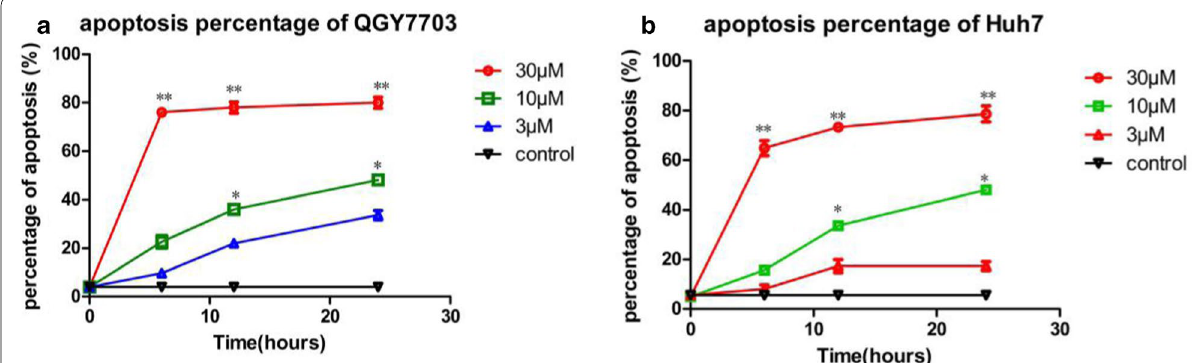
Fig. 3 Vanoxerine dihydrochloride treatment induced cell apoptosis. Vanoxerine dihydrochloride treatment at at 3, 10, 30μMconcentration for 6, 12, 24 h significantly increased the percentage of apoptosis in a QGY7703 and b Huh7 cell lines in a dose‑and time‑dependent manner. *p < 0.05, significantly different from the control PBS treatment